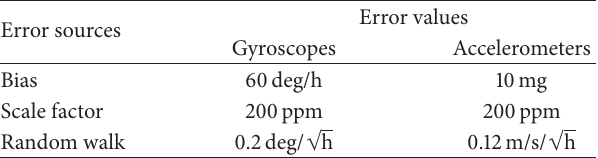
Table 3: IMU error